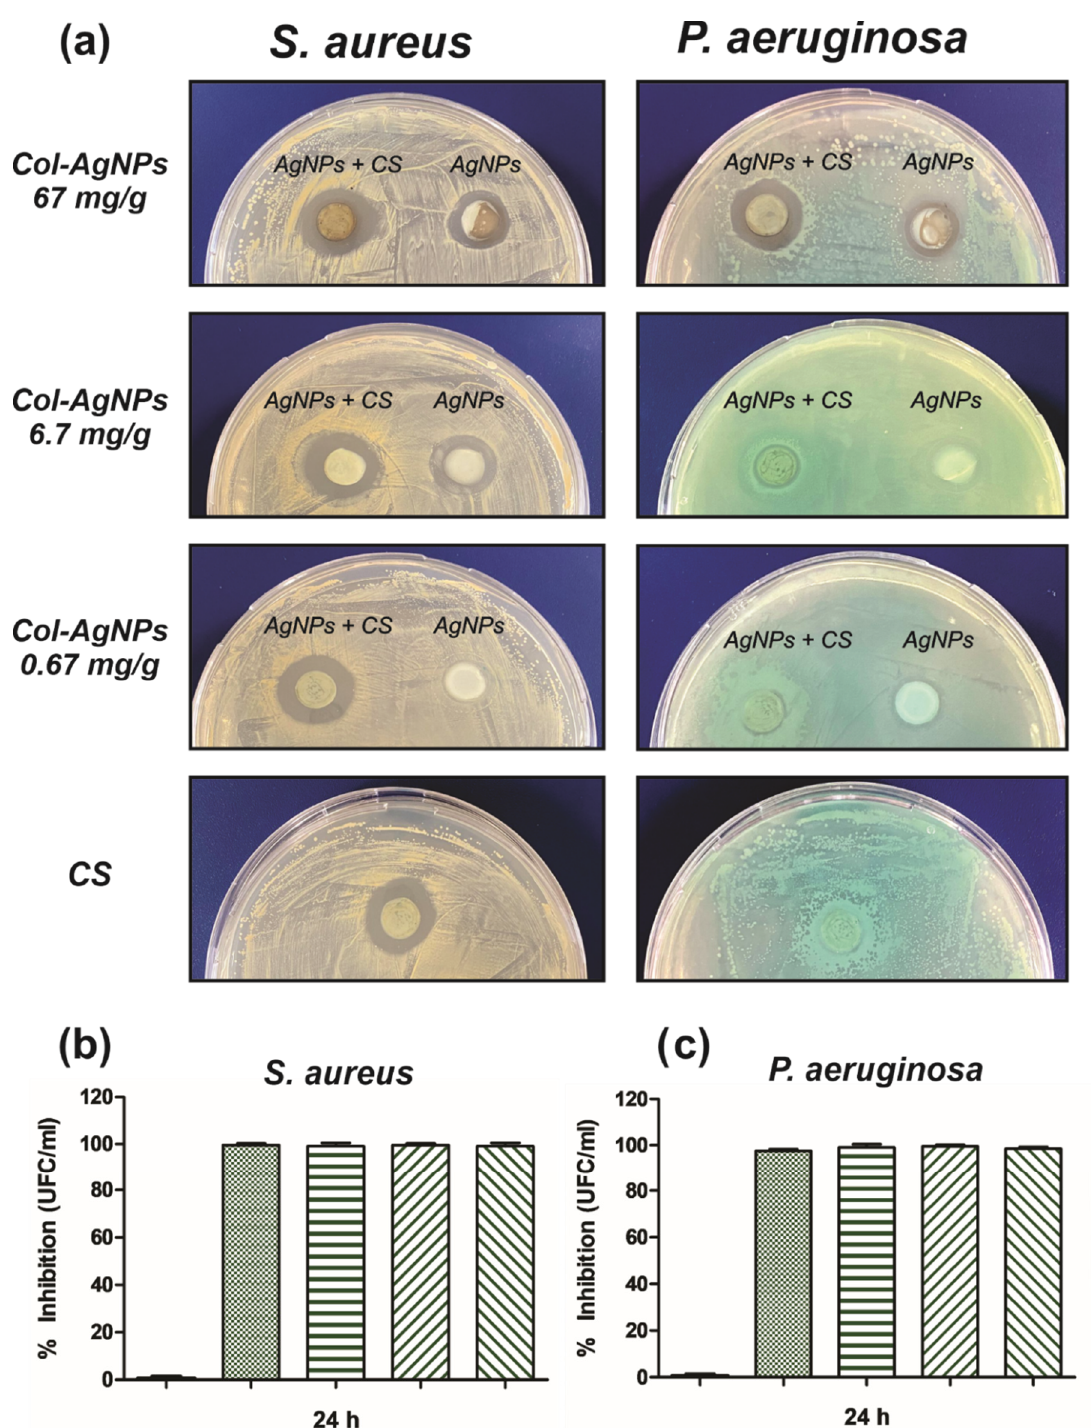
Figure 9 . Antimicrobial activity of Col-CS-AgNPs against S.aureus and P. aeruginosa . ( a ) Disk diffusion method for Col-CS and Col-AgNPs 67, 6.7 and 0.67 mg/g containg or not CS, against S. aureus and P. aeruginosa . ( b ) Percentage of inhibition of the growth of S. aureus ( b ) and P. aeruginosa ( c ) evaluated by the dilution method.